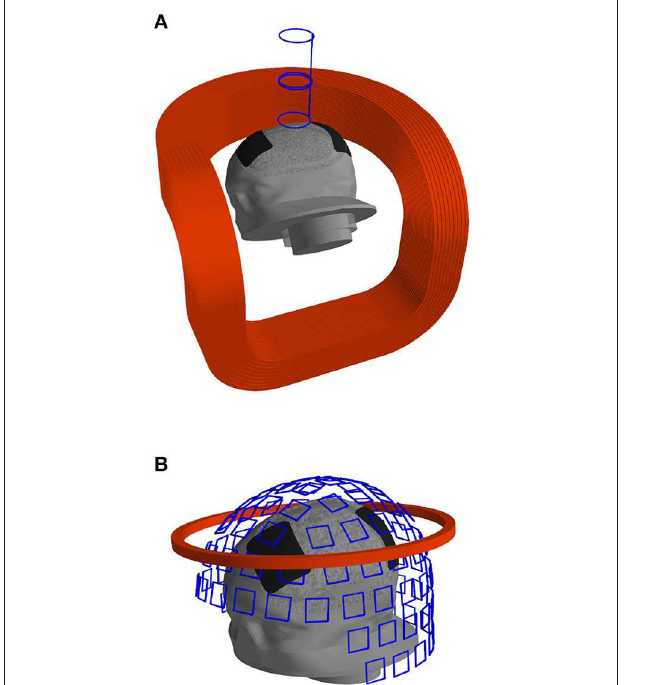
FIGURE 5 | Comparison of measured and simulated MRI images. (A) shows the utilized setup, including the polarizing coil (red), the spherical phantom (gray), and the receiver coil of the sensor (blue). Central slices of reconstructed images, not corrected for the sensitivity profile, are presented for measurement (B) and simulation (C) . Please note that the actual phantom contains a mount for dipolar current electrodes, which is recognizable in the central lower half of the reconstructed measurement, but was not accounted for in the